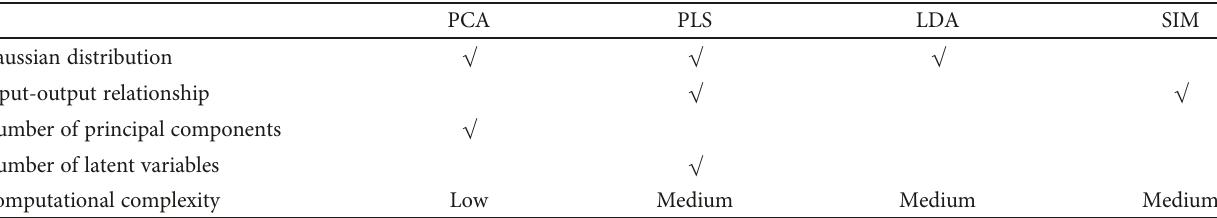
Table 4: A brief comparison among basic data-driven